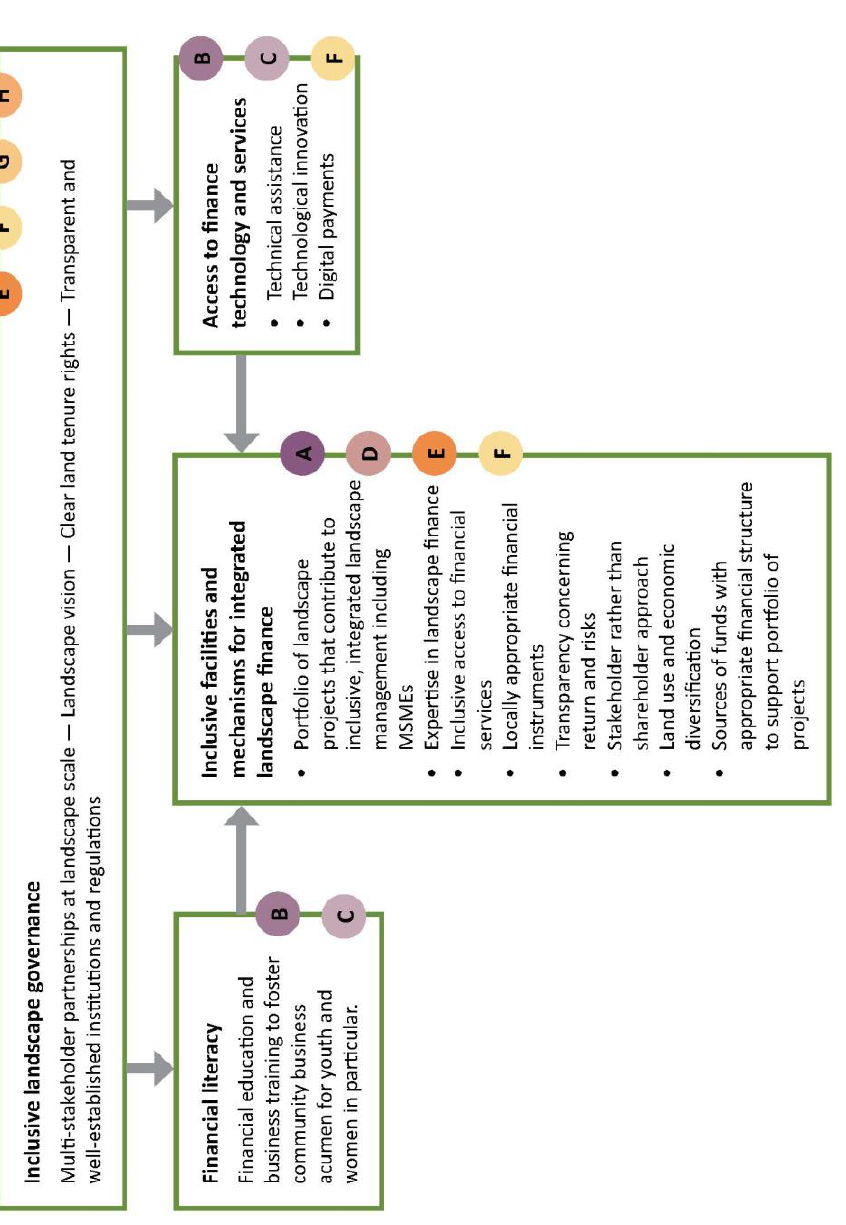
Figure 3. The four domains that facilitate the inclusion of MSMEs in landscape finance. Legend: The circled letters represent the challenges listed in Table 1 that are addressed by each domain: A product characteristics; B livelihood assets; C knowledge of agriculture and forestry sectors; D scale and costs of services; E transparency, trust, governance, and financial infrastructure; F production, climate, price, and policy risks; G information, communication, and roads; H other benefits, policies, and regulations.